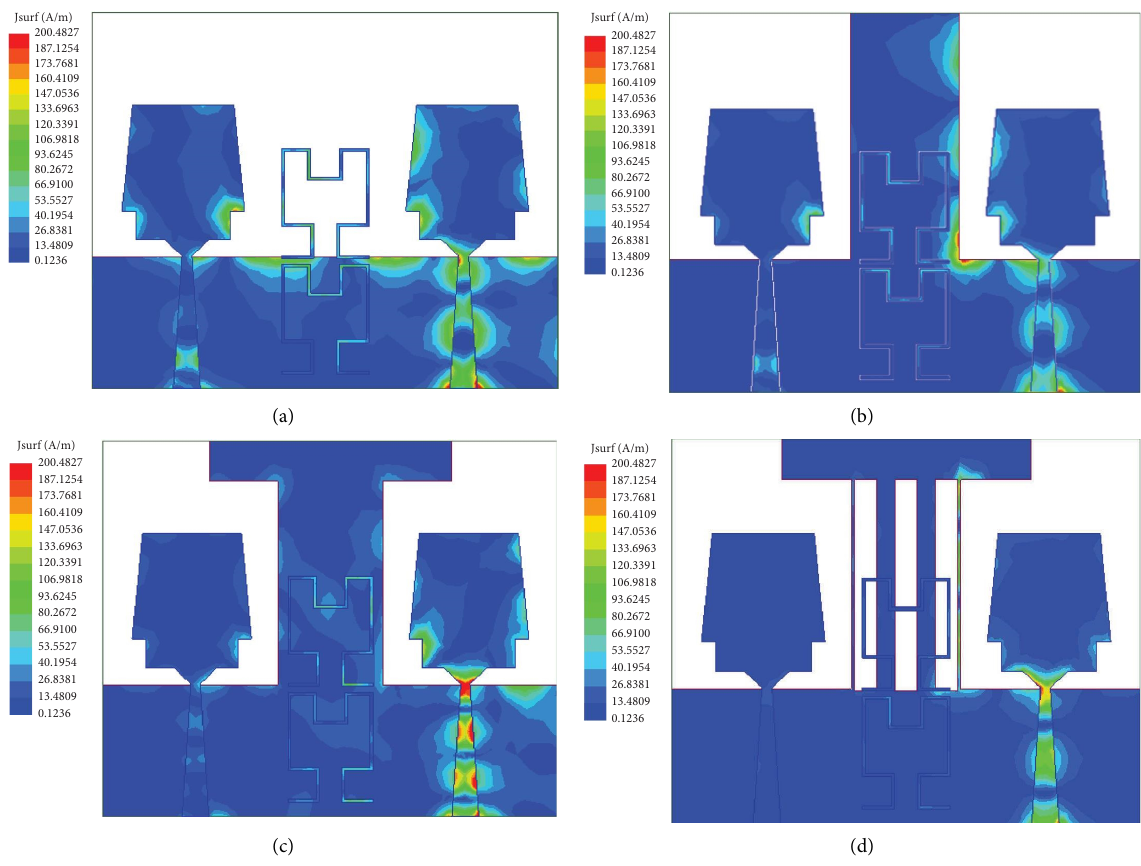
Figure 9: Current distribution of SWB-MIMO antennas at 16GHz for diferent decoupling structures. (a) Antenna 5. (b) Antenna 6. (c) Antenna 7. (d) Antenna 8.